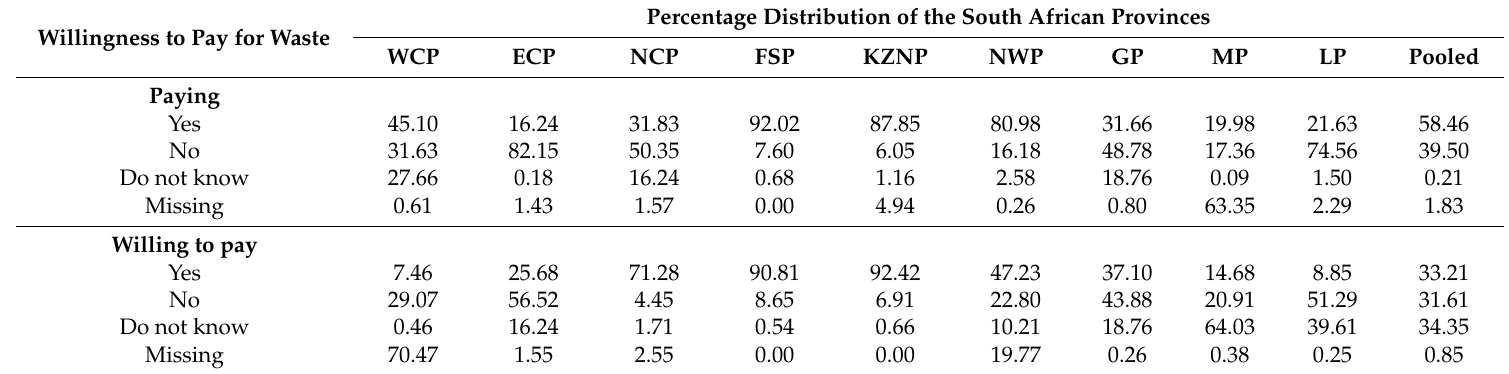
Table 4. Percentage distribution based on paying and willingness to pay for waste disposal.